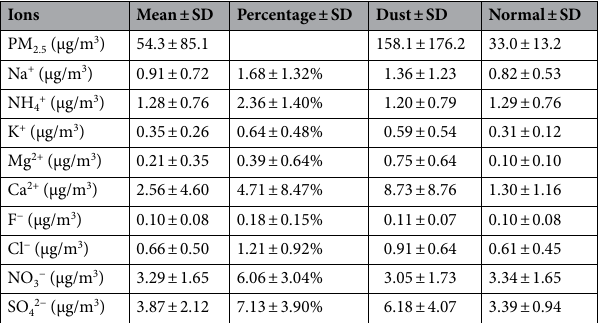
Table 1. Average PM 2.5 and water-soluble ion concentrations for whole spring, dust storm days, and normal days in the spring of 2021 in Lanzhou, China. SD means standard